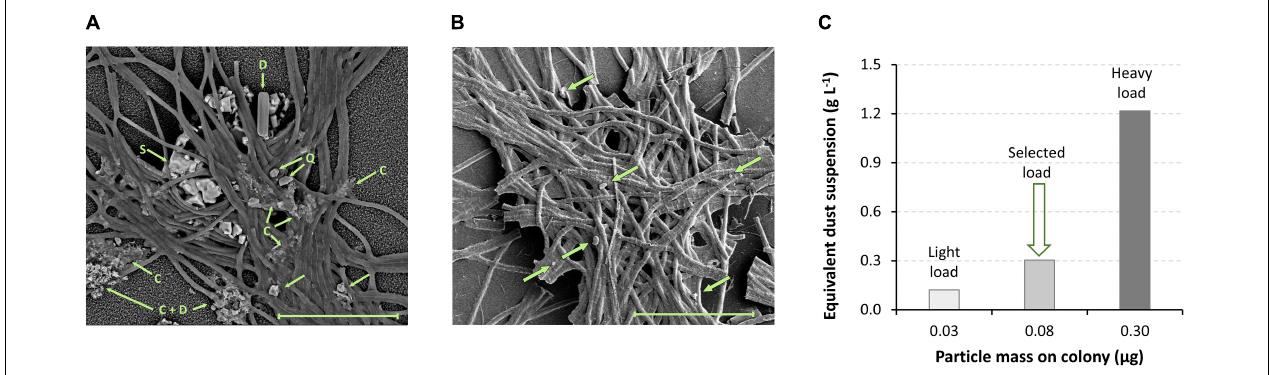
FIGURE 1 | Particle load on Trichodesmium colonies. Puff shaped Trichodesmium colonies, collected in the Gulf of Aqaba, contain variable loads of mineral particles. (A,B) SEM-EDS analyses of colonies collected on (A) July 10, 2017 and (B) December 9, 2014 were used to estimate the mass of particles on a colony; dust particles are marked with arrows. Colony A is heavily loaded with particles, containing numerous patches of small particles and a few larger particles; particle mass ∼ 0.3 µ g (calculation explained in section “Estimation of Dust Loads on Trichodesmium Colonies”). Particles with known mineralogy are marked: C, clay/mica minerals; S, NaCl (precipitated during drying); Q, quartz; D, diatom frustule. Colony B has a light load, containing only a few single particles; particle mass ∼ 0.03 µ g. (C) Equivalent particle suspensions were calculated for the heavy and light particle loads, assuming a colony volume of 0.25 µ l. The dust suspension concentration of 0.3 g L − 1 , used in this work, is equivalent to 0.08 µ g of dust per colony, which lies within the range of natural observations. Scale bar = 100 µ